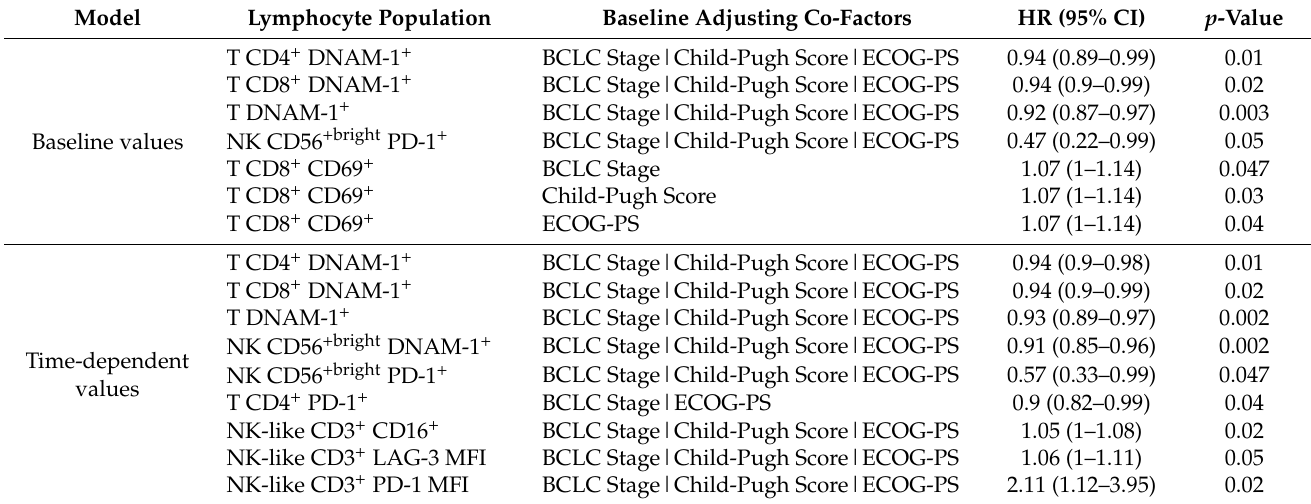
Table 3. Baseline and time-dependent multivariate Cox regression models between immune checkpoints expression in T and NK lymphocytes and the probability of developing eDAEs during the first 8 weeks of sorafenib treatment. Model